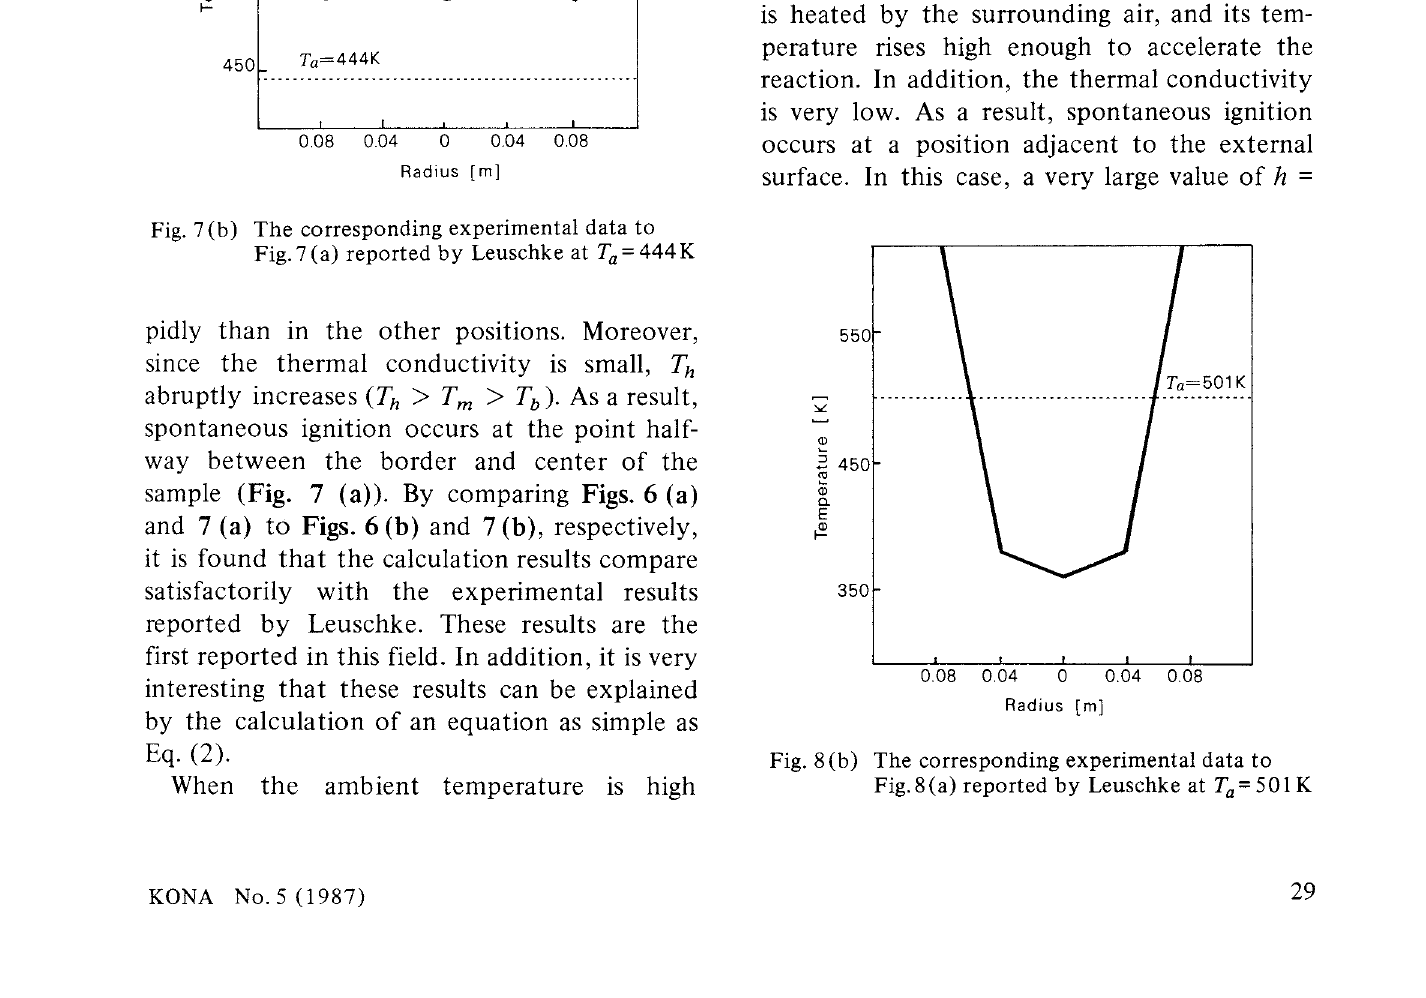
Radius [m] Temperature profile of cork dust deposit showing the moment immediate before the ignition at Ta =50 1 K. Solid line refers to the values after 1.08 h; dashed line refers to the values after 1.086h